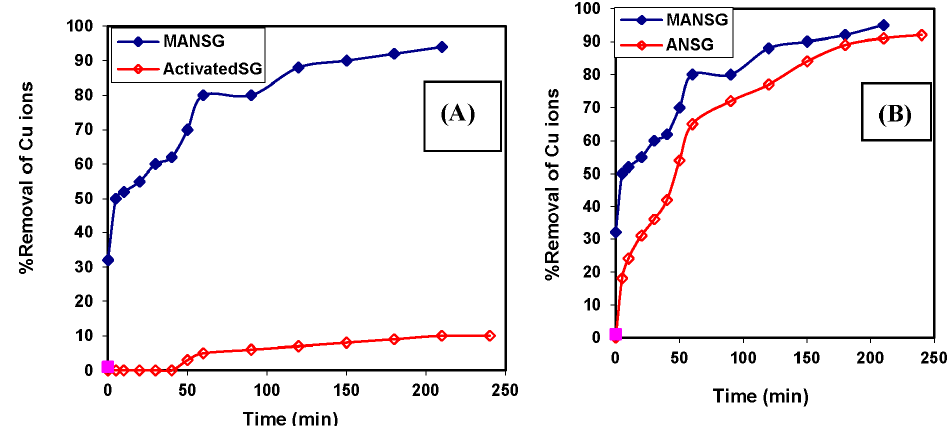
Figure 9. Comparable investigation of the influence of contact time on copper sorption process: ( A ) for both MANSG and its parent activated silica gel (Activated SG); ( B ) for both MANSG and its parent amine-functionalized nano-silica gel (ANSG). Solution concentration of ion = 1000 ppm; amount of adsorbent = 0.25 g; agitation speed = 200 rpm; solution volume = 25 mL; pH = 7.